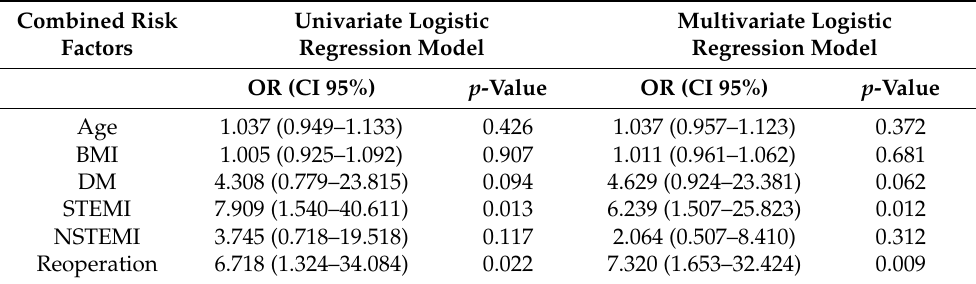
Table 5. Univariate and multivariate logistic regression models of hospital